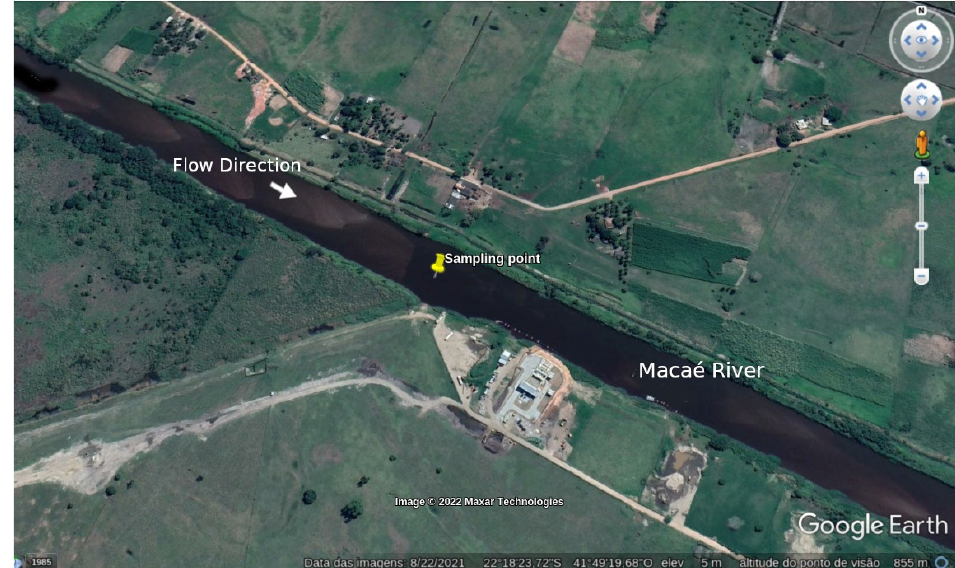
Figure 2. Macaé River. Figure 2. Maca é